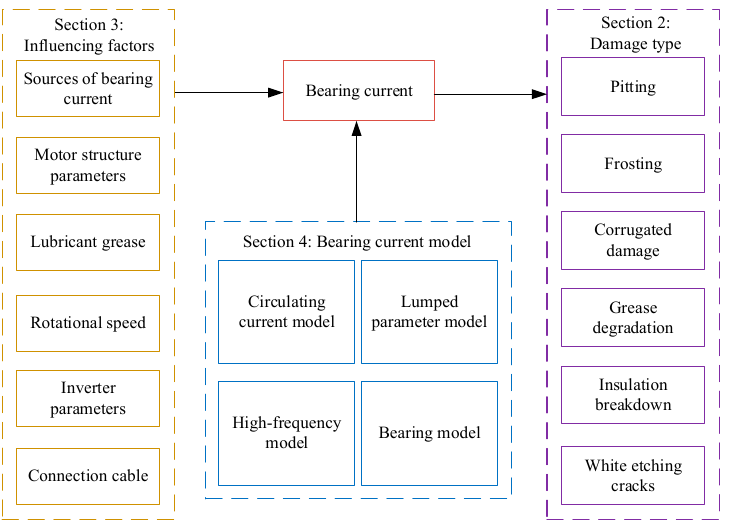
Figure 1. Relationship diagram of bearing current research content.